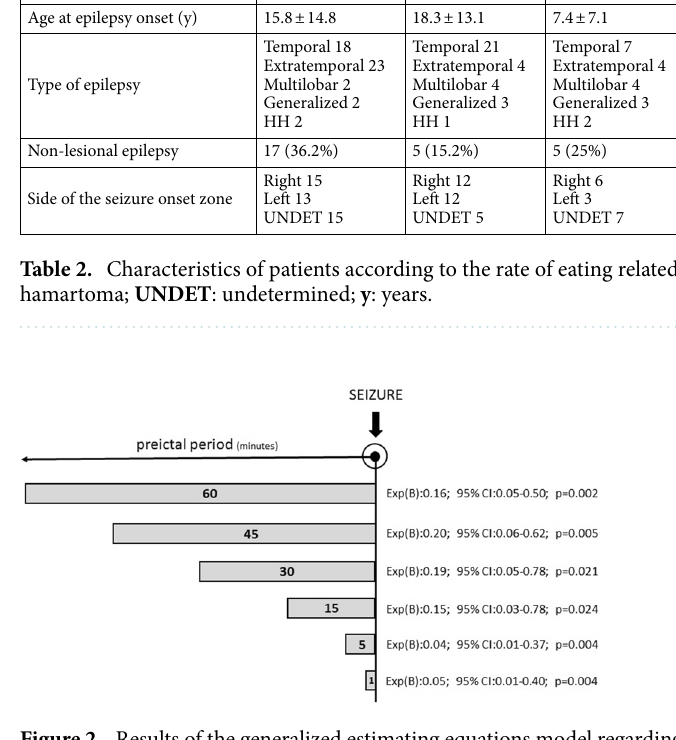
Figure 2. Results of the generalized estimating equations model regarding the effect of eating—subinterval analysis according to Method